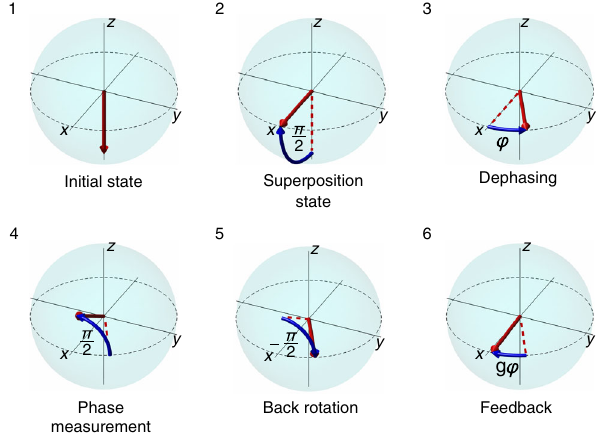
FIG. 2. Bloch-sphere representation of the phase lock between the LO and the atomic superposition state. The phase lock between the classical oscillator and the atomic spin is obtained using repeated, time-correlated Ramsey interrogations and feed- back. The sequence begins by preparing the atomic CSS in the j ↓ i state via optical pumping (step 1). The measurement of the relative phase between the CSS and the LO starts when a π = 2 microwave pulse around the y axis brings the CSS into a balanced superposition of the j ↓ i and j ↑ i states, depicted as a vector on the equatorial plane of the Bloch sphere (step 2). The x axis is chosen to represent the phase of the local oscillator and φ the relative phase between the LO and the atomic superposition that evolves FIG. 1. Experimental scheme. The evolution of the LO phase φ because of the LO noise (step 3). After an interrogation time T , is compared to the phase φ of an atomic ensemble in a LO at the projection of φ is mapped onto a population difference by a superposition state using coherence-preserving measurements in projection π = 2 pulse around the x axis and read out with the a Ramsey-spectroscopy sequence. The relative phase is obtained coherence-preserving detection (step 4). The CSS is rotated from the readout of the population difference and is used to back to the equatorial plane by a reintroduction π = 2 pulse around implement the phase lock between the two oscillators by applying the x axis (step 5), and feedback is applied on the phase of the LO a feedback correction phase φ on the LO output using a phase FB (step 6). The PLL between the LO and the atomic ensemble actuator. The light shift induced by the optical trap and by the consists in the repetition of the steps from 3 to 6, potentially until probe has been engineered to have a homogeneous measurement the atomic ensemble shows a residual of the atomic ensemble [28].